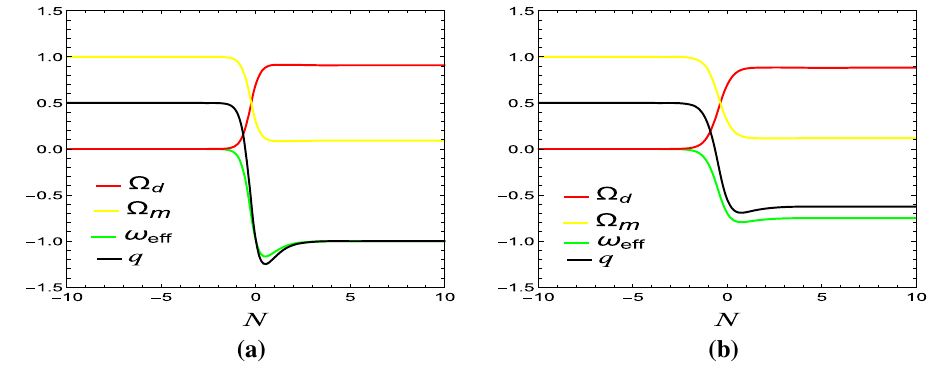
Fig. 3 The figure shows the time evolution of the physical parameters (cid:7) (cid:7) ω d , m , ef f and q for the autonomous system (12). In panel a for ω = 1 . 5, λ = 0 . 1 and γ = 0, the effective equation of state param- m eter crosses the phantom divide line. Ultimate fate of the accelerated